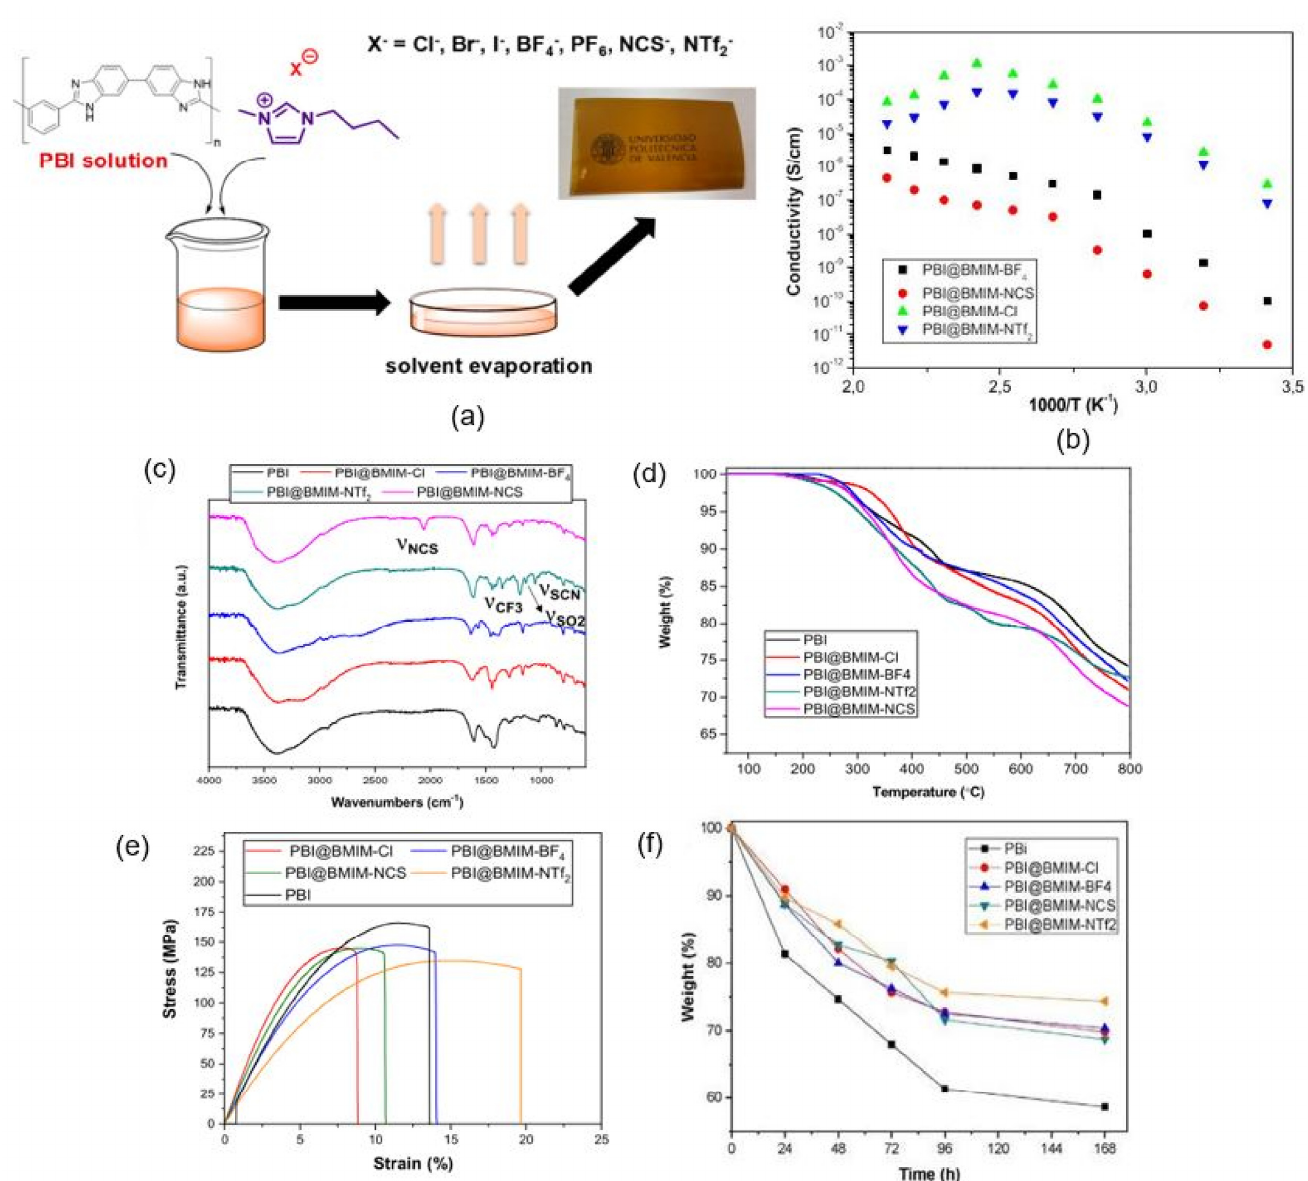
Figure 11. ( a ) Schematic preparation of PBI membrane containing BMIM ionic liquid compounds with different anions, ( b ) conductivity test, ( c ) FT-IR results, ( d ) TGA results, ( e ) stress–strain curves and ( f ) Fenton’s test